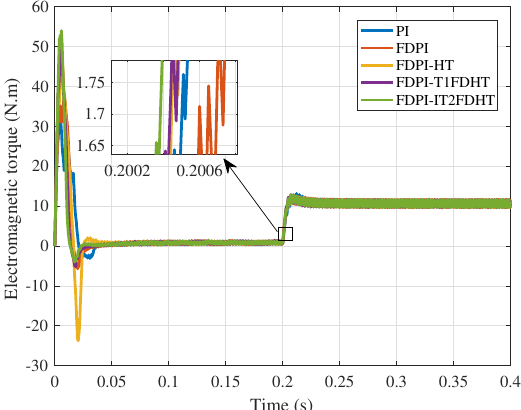
Figure 15. Electromagnetic torque response results in the load